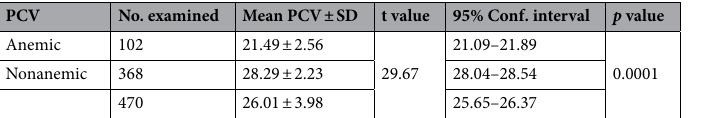
Table 1. Multivariate logistic regression of host factors and prevalence of bovine babesiosis.